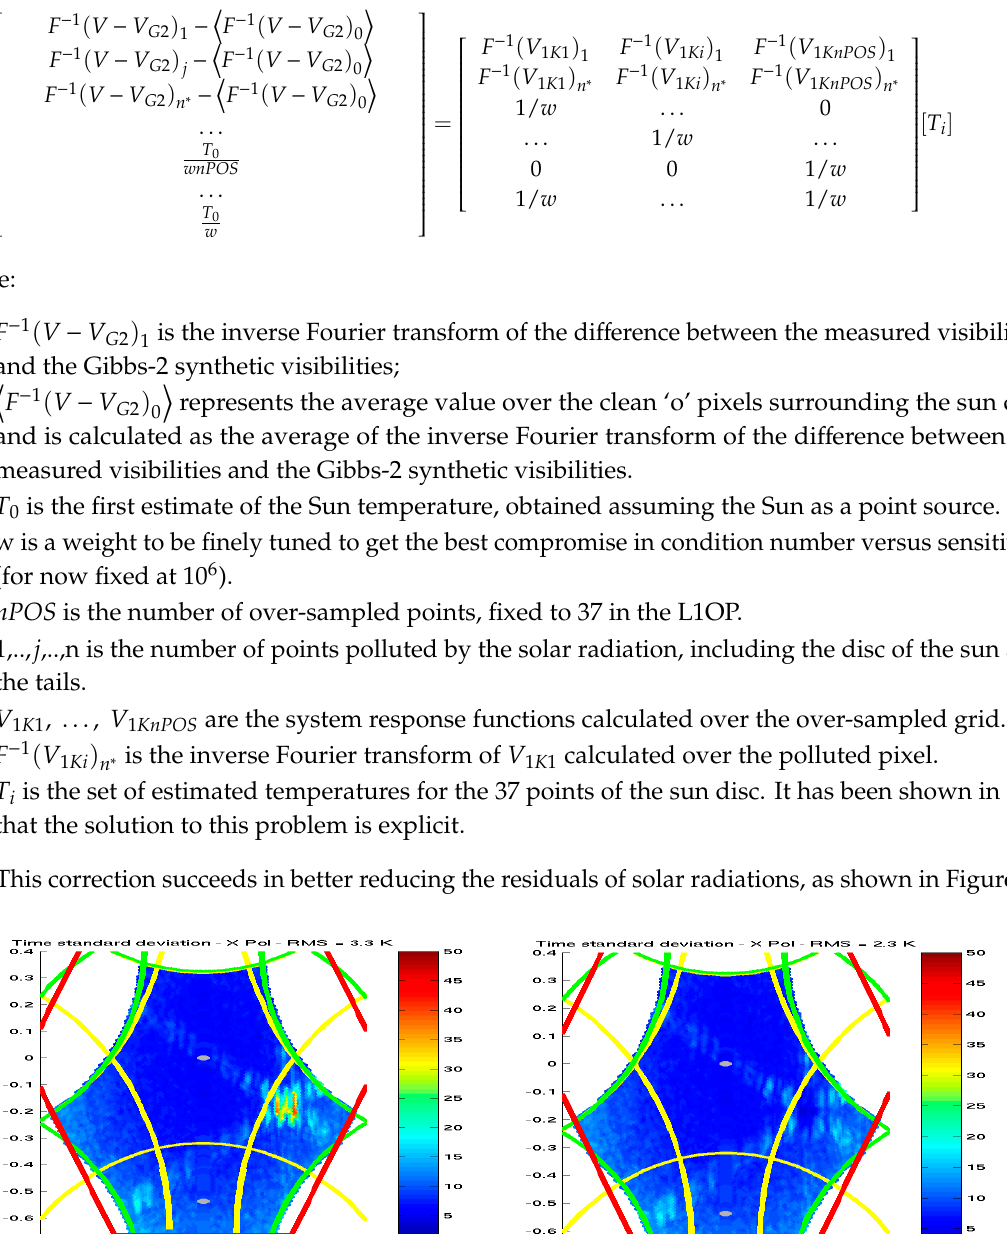
( b ) Figure 14. SMOS biases from a measurement in the Pacific after removing the expected forward model when the Sun is in the back of the instrument before ( a ) and after ( b ) the Sun BT correction in the back [18]. 3. Results and Discussion